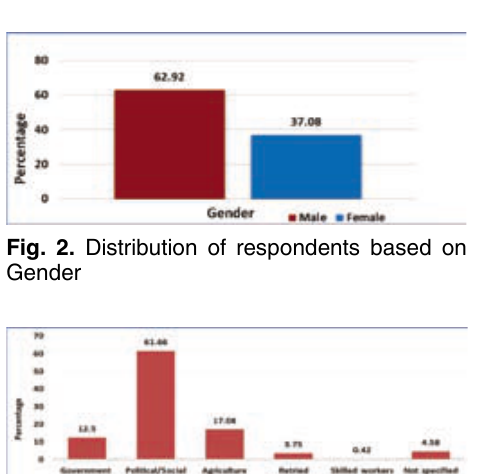
Fig. 1. Distribution of respondents based on age